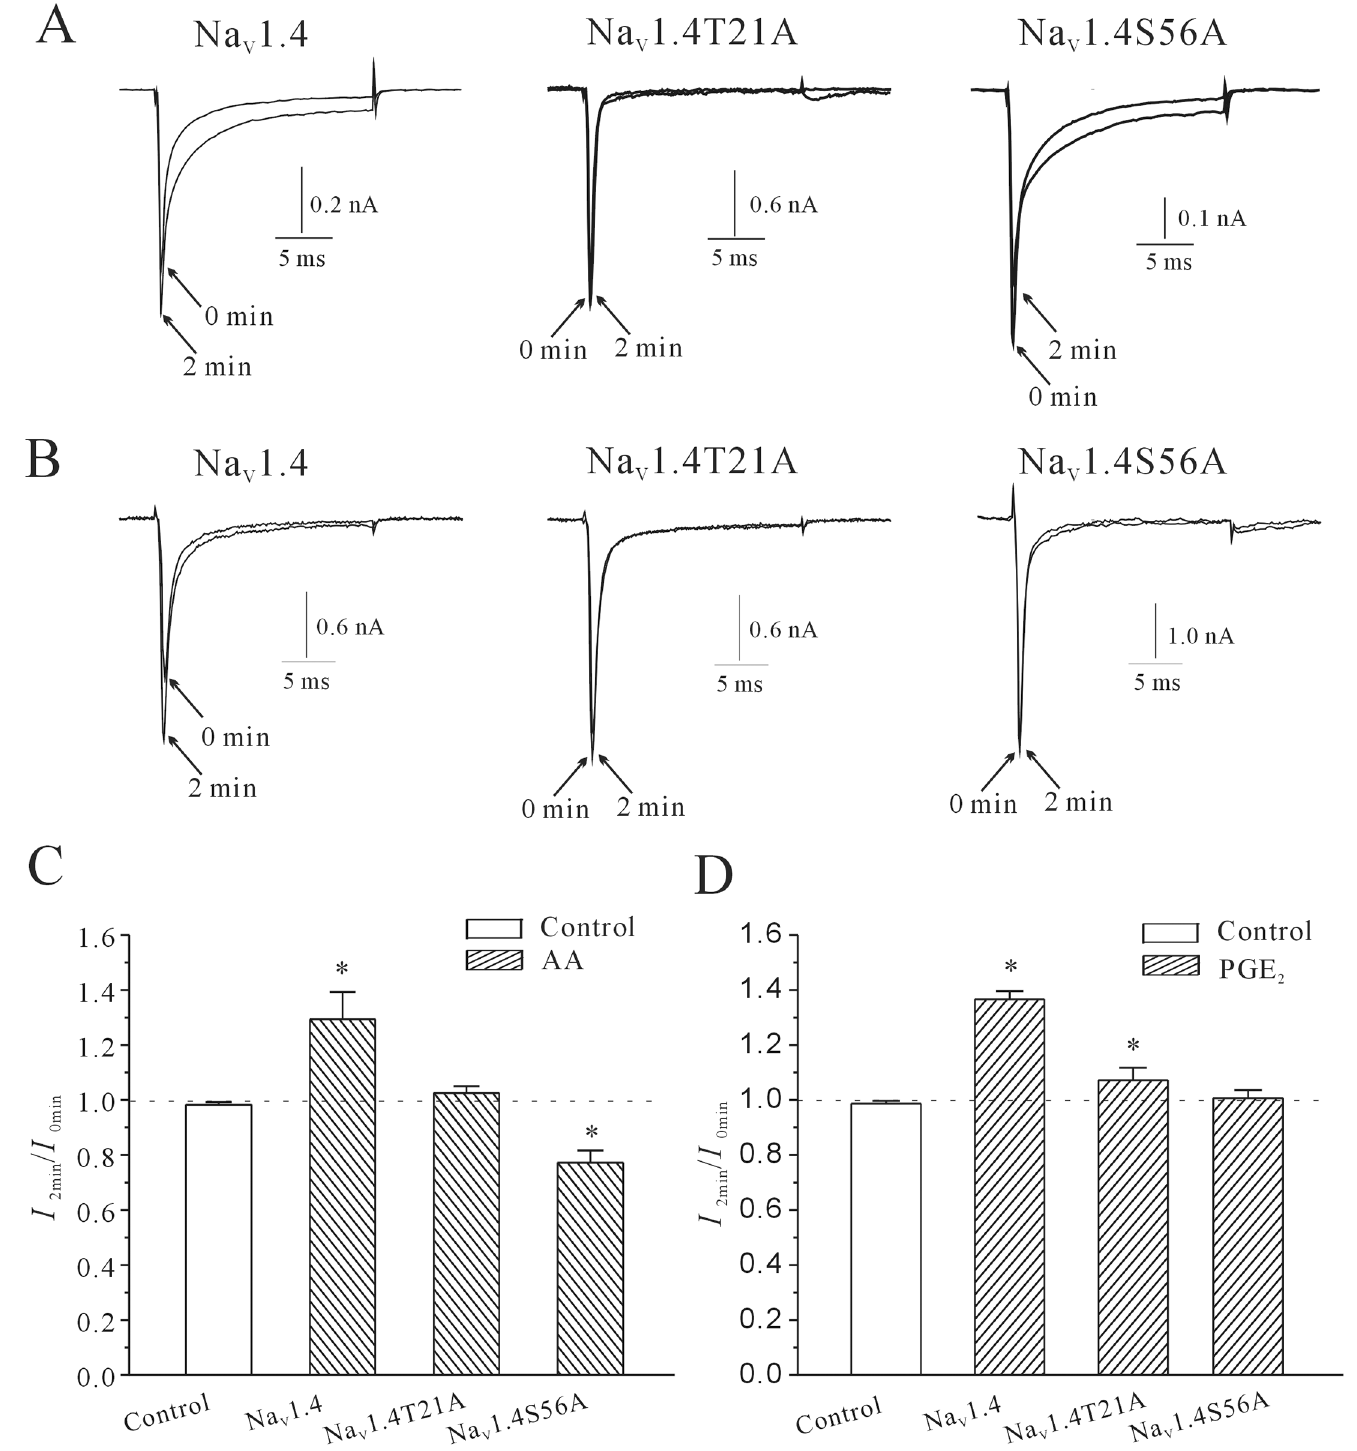
Fig 10. The effects of AA/PGE 2 on currents in sodium channel mutants rNa V 1.4T21A and rNa V 1.4S56A. (A) Current traces taken at the initial time point (0 min, at membrane rupture) and after intracellular application of 10 μ M AA for 2 min in wildtype rNa V 1.4 and mutants rNa V 1.4T21A and rNa V 1.4S56A. (B) Current traces taken at the initial time point and after intracellular application of 10 μ M PGE 2 for 2 min in wildtype rNa V 1.4 and mutants rNa V 1.4T21A and rNa V 1.4S56A. (C) Statistical analysis of the effects of internal AA and PGE 2 on currents in wildtype rNa V 1.4 channels and mutant rNa V 1.4T21A and rNa V 1.4S56A channels. Results are mean ± S.E.M. from four to six cells. * , P < 0.05, compared to control, using the Student ’ s t test.